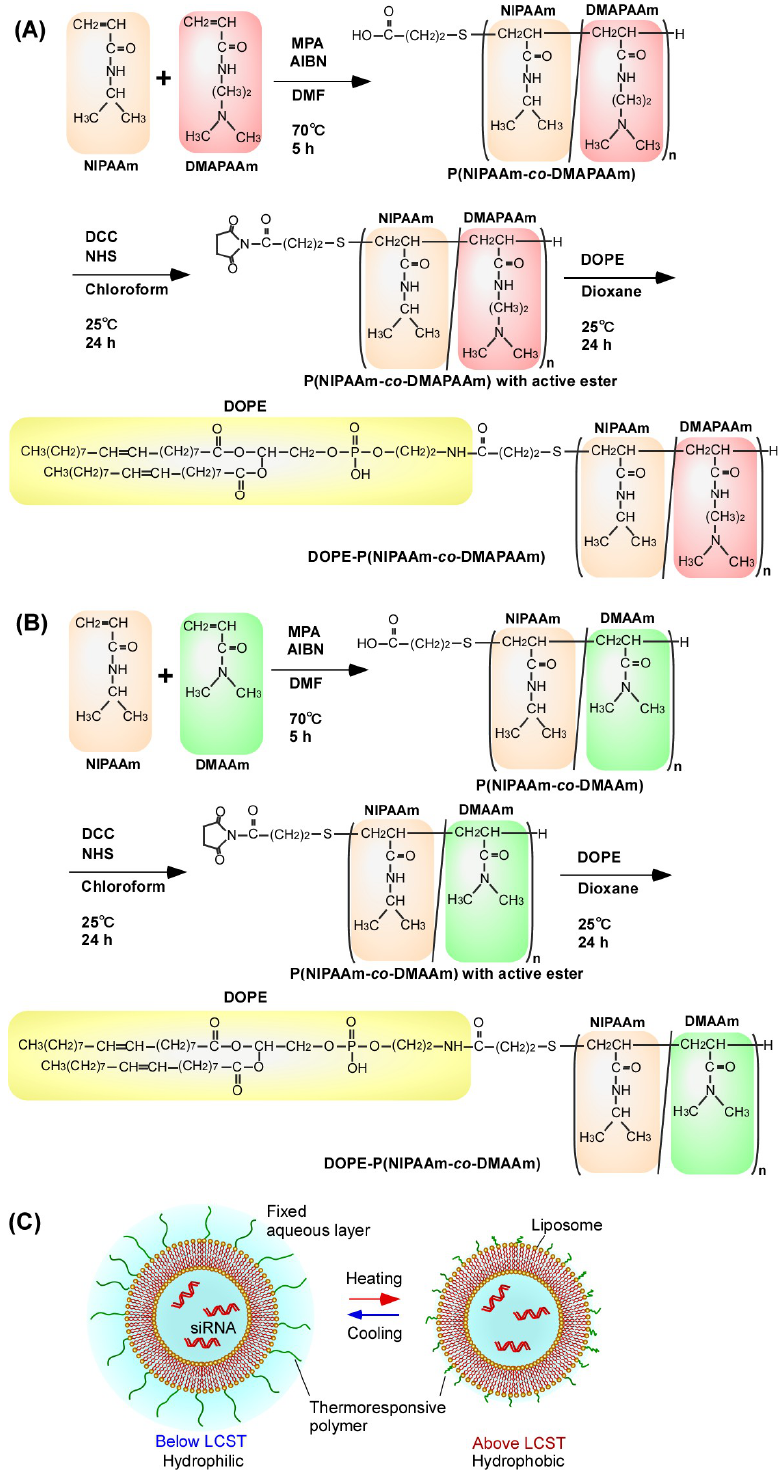
Figure 1. Schemes for the preparation of ( A ) P(NIPAAm- co -DMAPAAm) modified DOPE and ( B ) P(NIPAAm- co -DMAAm) modified DOPE. ( C ) Illustration of a thermoresponsive polymer-modified liposome as an siRNA carrier.